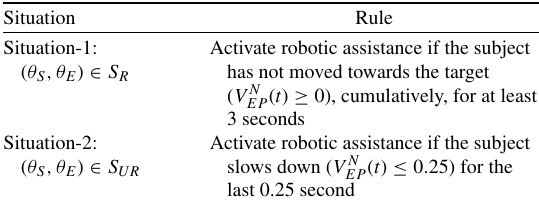
Table 2 Description of the rules used by the motion detection module in the